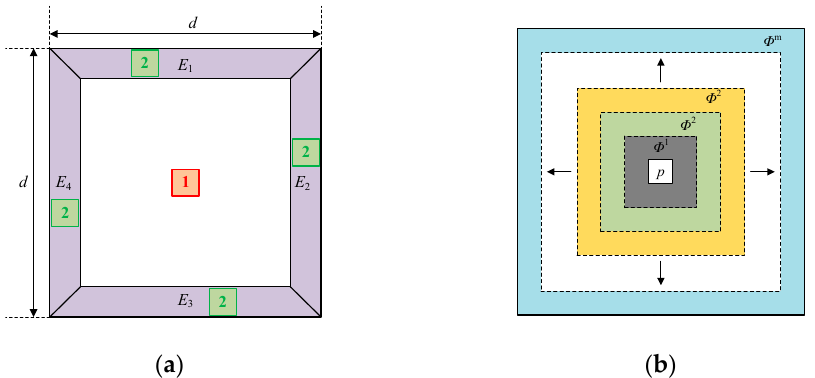
Figure 6. Schematic diagram of LGD. ( a ) Labeling strategy, E 1 - E 4 are the four sides of the local area, the center pixel is labeled as class 1, and the minimum points on the four sides are labeled as class 2; ( b ) Local structure for computing MGDE.